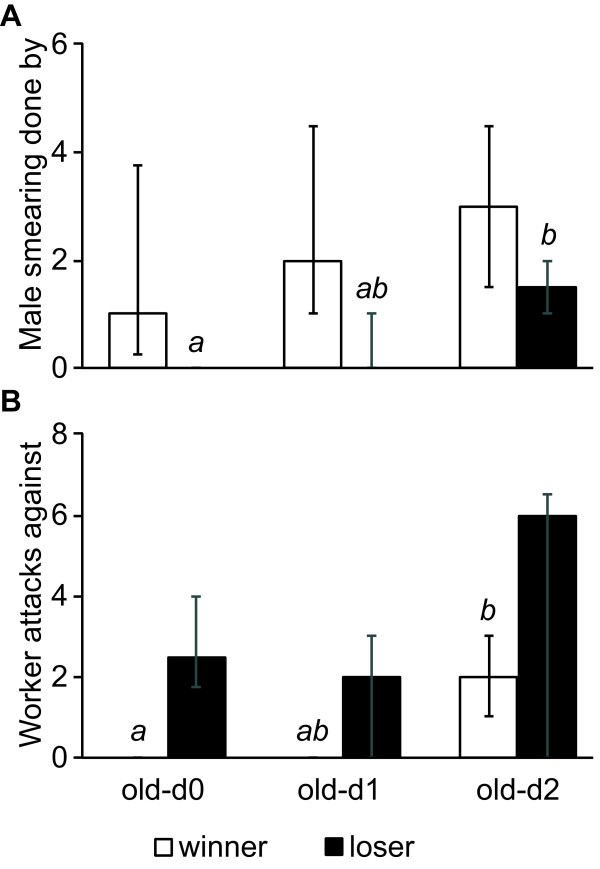
Male smearing and worker attacks in male-male fights of the ant Cardiocondyla obscurior. A) The frequency of observed male smearing performed by the later winner of the fight was independent of the age of the two males. Besmearing activity by the later loser increased with the age of the young male. B) Worker attacks towards the later loser of the fight did not vary with the age of the two opponents. The occurrence of worker biting against the later winner of the fight increased with the age of the young male. Bars represent median values and whiskers the 25% and 75% quartiles. Small italic letters indicate significance groups for significant overall differences (black bars in A and white bars in B).